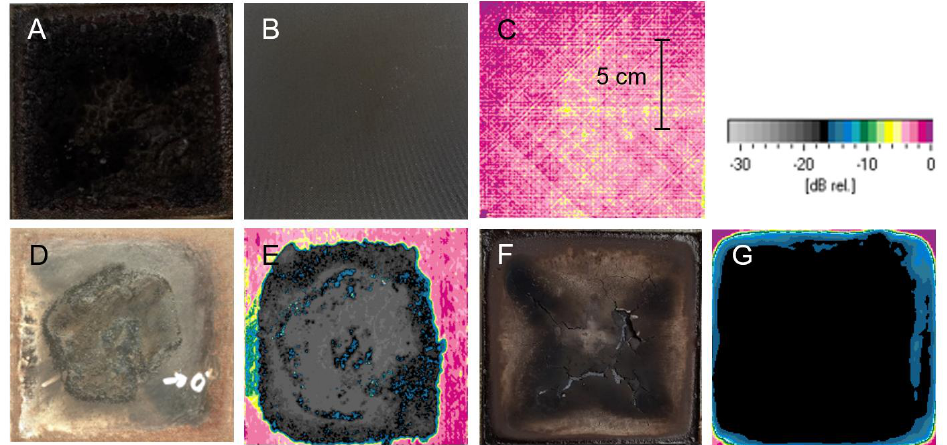
Figure 16. 2 mm thick 8552/IM7 samples after impact of 40 g fire accelerant: ( A ) CFRP with intumescent coating, ( B ) after removing the residues of the intumescent coating, ( C ) corresponding ultrasonic C-scan, ( D ) CFRP with copper mesh, ( E ) corresponding ultrasonic C-scan, ( F ) CFRP with copper mesh and coating, ( G ): corresponding ultrasonic C-scan.